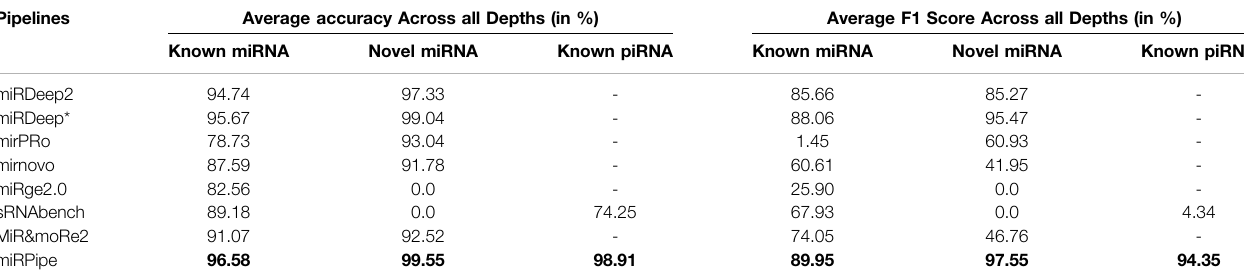
TABLE2| AverageperformanceofpipelinesforknownmiRNA,novelmiRNAandknownpiRNAs.Thecellswith ‘ - ’ indicatesthatpipelinedoesnotidentifythatparticulartype of RNA.